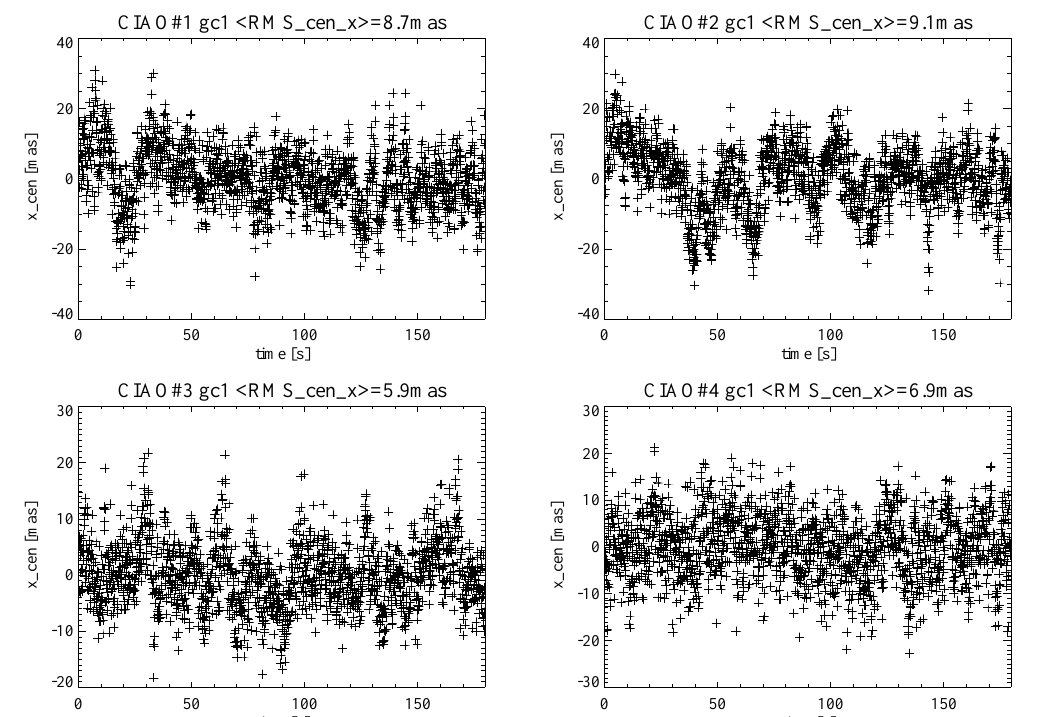
Figure 6. Residual image motion jitter along the x-axis (x_cen) over 150s observation of the GC. The title line shows the calculated rms value (RMS_cen_x) in mas.